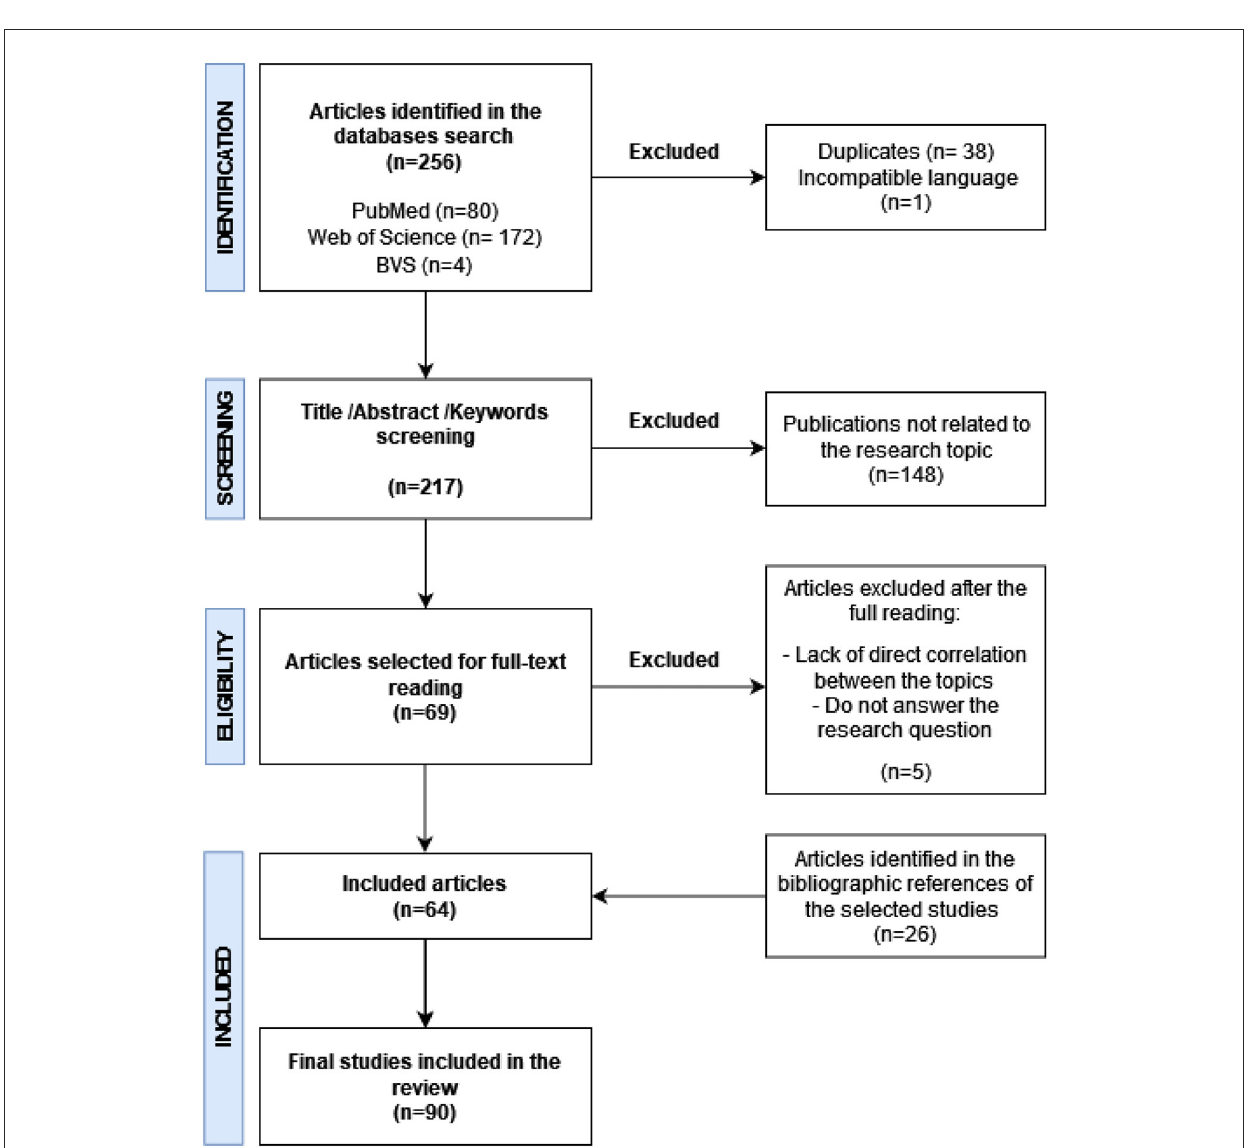
FIGURE1 Flowchart summarizing the article selection process adopted in this review. Elaborated by the